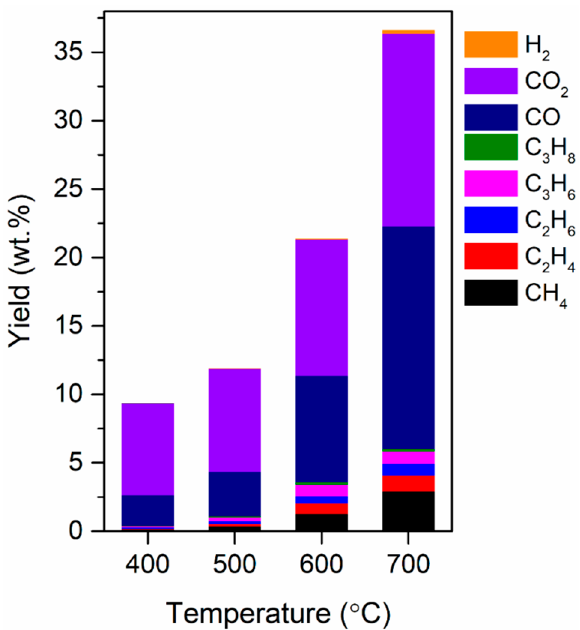
Figure 2. Yield of non-condensable gases (on the basis of the weight of the feedstock) produced via the pyrolysis of TBW at different pyrolysis temperatures. Mean values of replicates ( n = 3) are reported with standard deviations of approximately 7%.